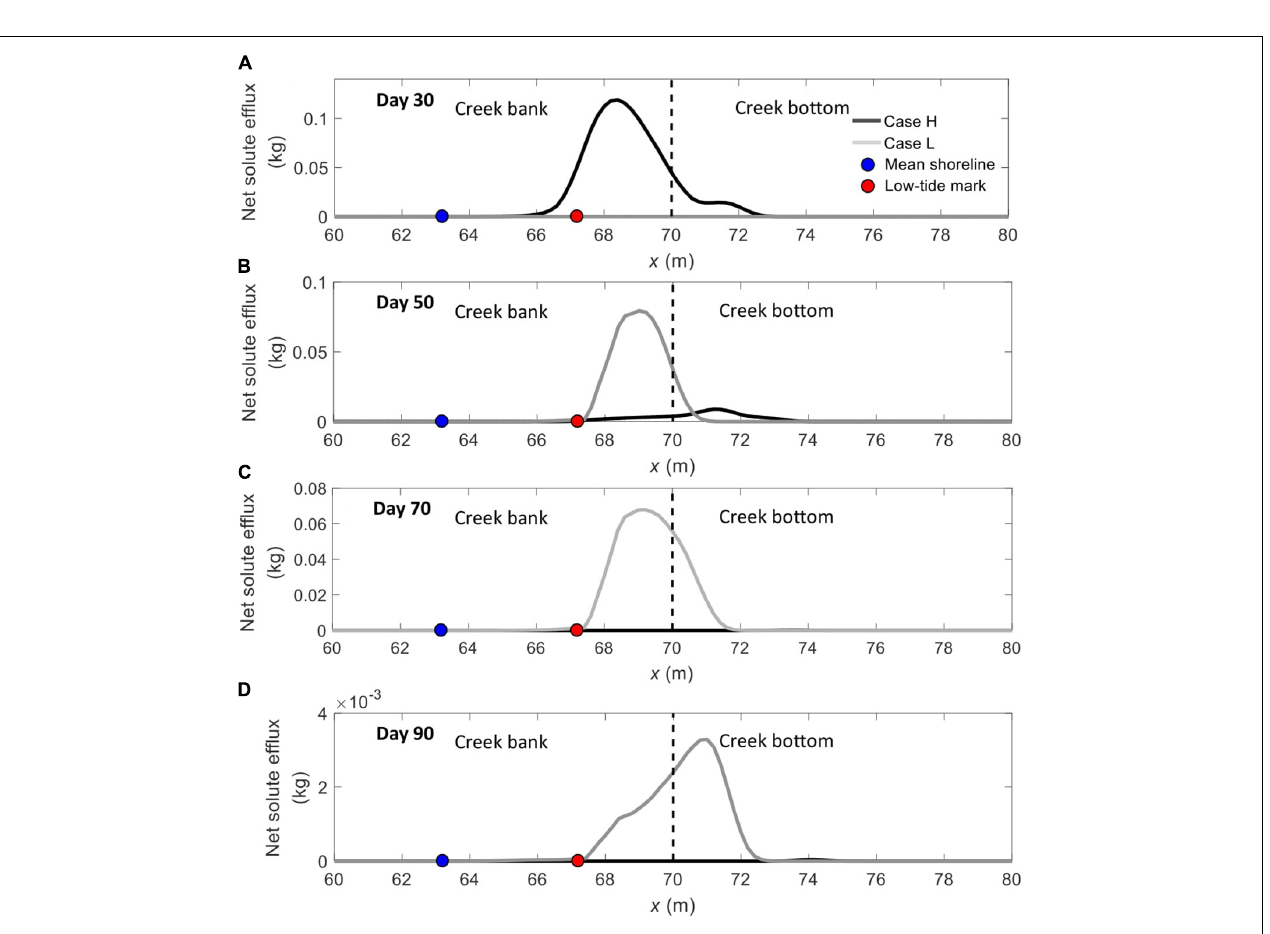
FIGURE 4 | Temporal variations of daily integrated solute effluxes across the sediment–water interface (BCDE in Figure 1) between Cases H and L on (A) Day 30, (B) Day 50, (C) Day 70, and (D) Day 90. The blue and red nodes represent the mean shoreline and low-tide mark, respectively, while the vertical dashed line separates creek bank (left) and creek bottom